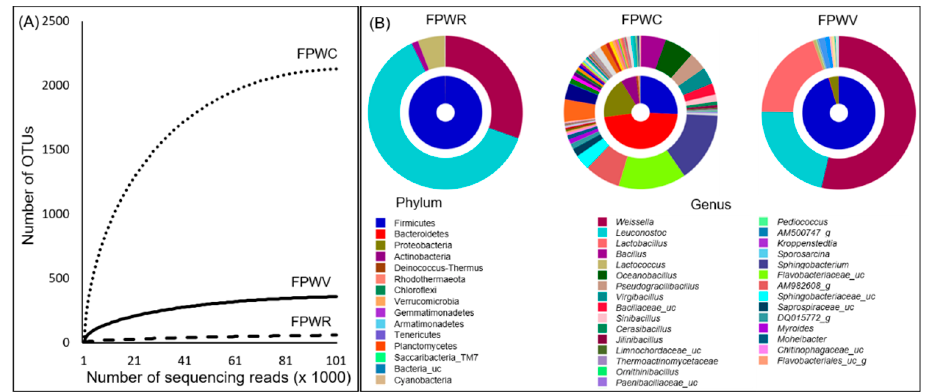
Figure 1. Rarefaction curve and bacterial distribution in FPW samples ( A ) The rarefaction curve of observed species which were evaluated by 16S sequences. ( B ) Double pie charts of bacterial communities in FPW samples. The inner and the outer circle indicate the phylum and the genus compositions of the bacterial communities.